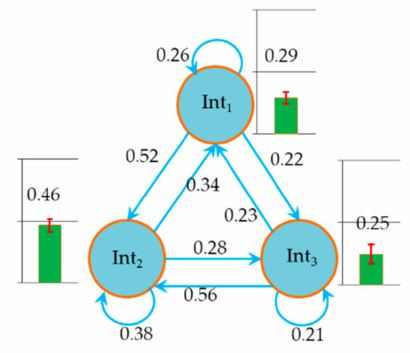
Figure 6. Transition probability between driver’s intention states in the HMM.